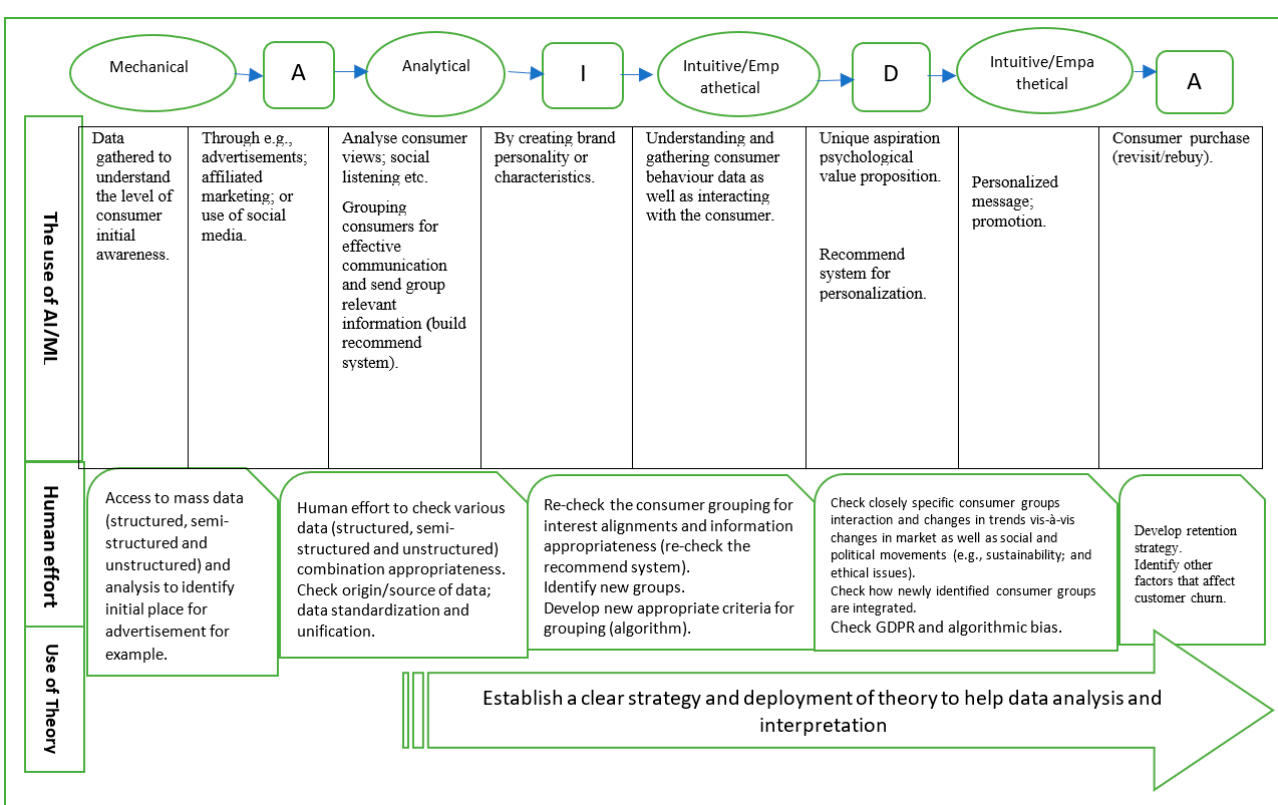
Figure 4. Reducing digital myopia—the link between the AIDA model and AI/ML. Source: The au- thors.